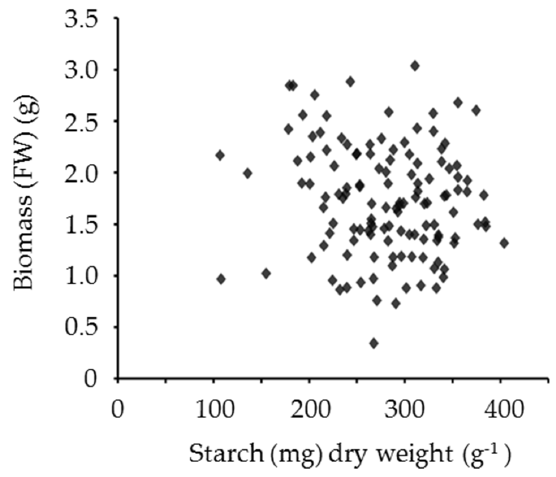
Figure 5. Biomass yield does not correlate with starch concentration in 128 red clover genotypes. The starch concentration and biomass were measured in 50 day old red clover plants grown under controlled growth conditions with a fluence rate of 200 µ mol · m 2 · s − 1 in a 14:10 light/dark, 13–14 ◦ C/18–19 ◦ C diel cycle and harvested at the end of the day. Details are described in Supplementary Methods.